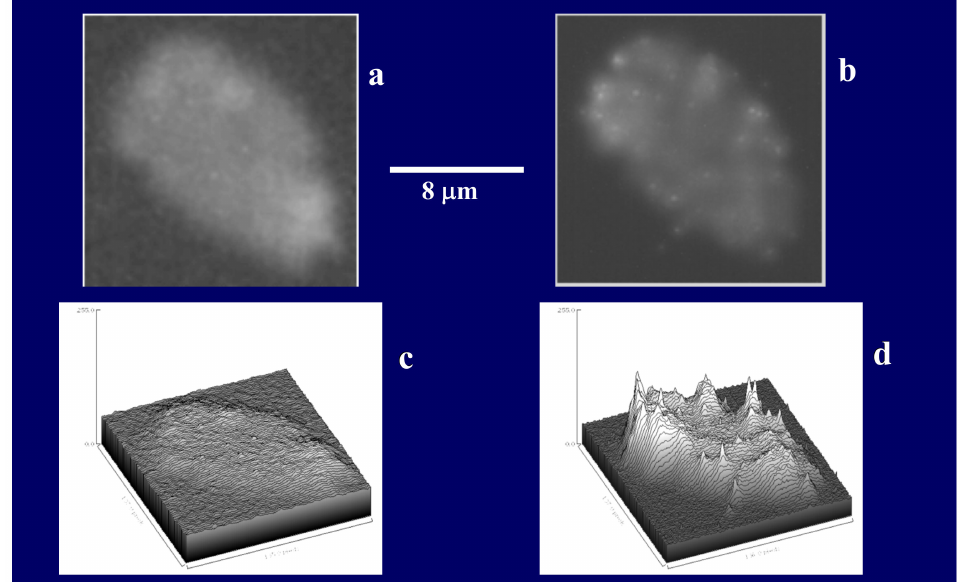
Figure 22. These images illustrate the advantage of using computer-processed thin sections of confocal imaging to eliminate out-of-focus image noise and precisely count the number of MB per section of gel. In here MG were labeled with CTC ( λ em = 560 nm), and MB labeled with BacLigh- Red TM ( λ em = 644 nm). Insert ( a ) is a raw fluorescence image across the whole gel labeled with both CTC and BacLigh-Red TM . Notice that that despite double fluoresces labeling, imaging across the whole MG does not allow to distinguish bacteria. Insert ( b ) shows a 300 nm thin gel section where bacteria can be readily observed. The corresponding 3D plots of contrast ratios of BacLigh-Red TM are in ( c ) and ( d ). Notice that the thin section in ( d ) shows both the perimeter of the MG depicted by CTC fluorescence and the number of MB which can be identified by the sharp contrast peaks of BacLight fluorescence. It allows serial section tomography software, developed in our laboratory [29], to readily quantitate bacteria lodged inside MGs, avoiding double-counting by defining the specific x-y coordinates of every peak in each thin section.